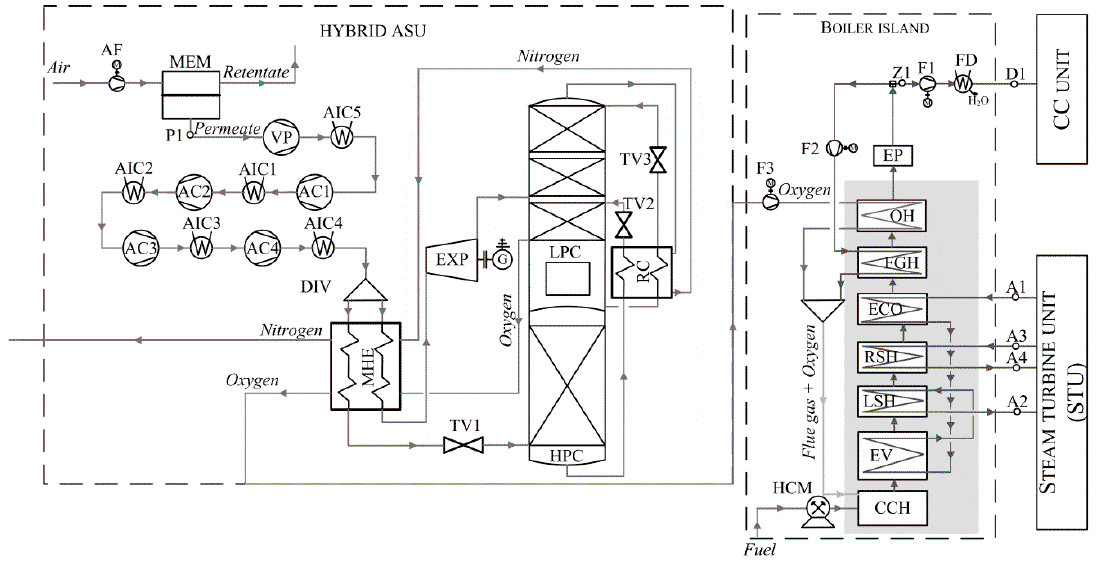
Figure 5. Scheme of the pulverized-fuel boiler integrated with a hybrid ASU (AF–air fan; HCM –hard-coal mill; MEM–membrane module; VP–vacuum pump). Table 4. Assumptions for the hybrid ASU (variant V2).